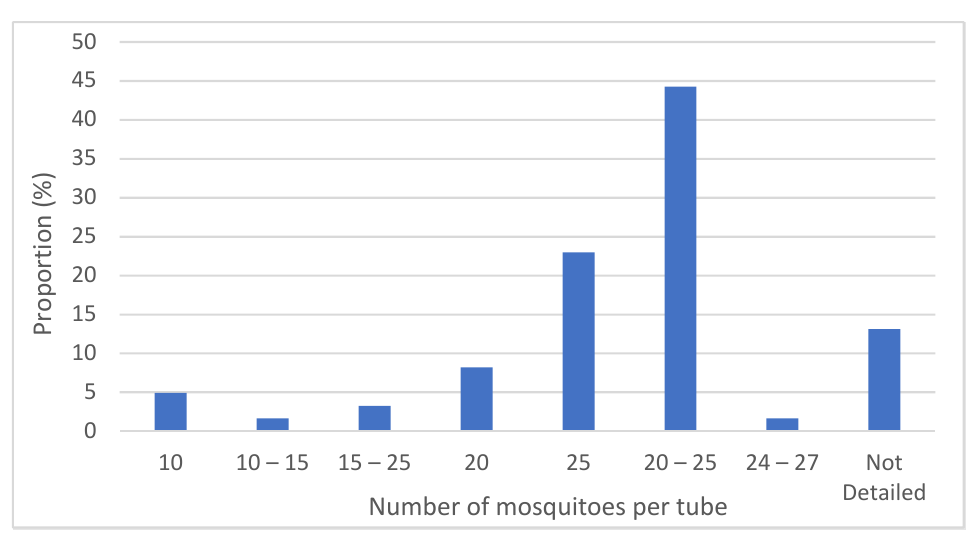
Figure 4. The number of mosquitoes used in an individual tube for publications reviewed.